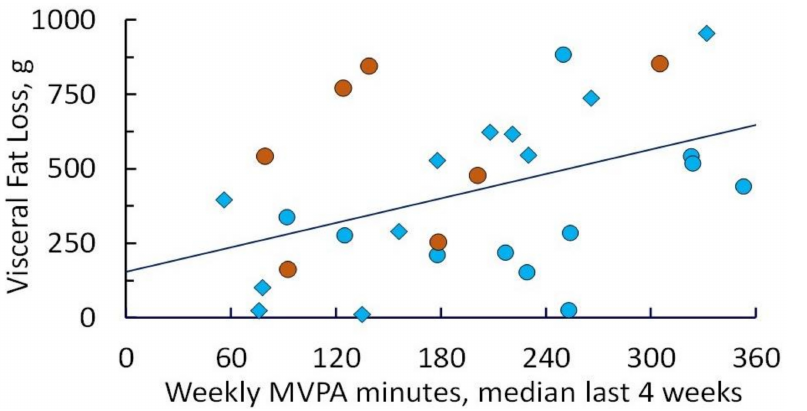
Figure 4. Visceral fat lost (percent relative to baseline) as assessed by iDXA after 12 and 24 weeks of intervention, plotted as a function of weekly MVPA achieved (median of recorded values for weeks 9–12 or weeks 21–24). Diamonds denote participants in cohort 1; circles denote participants in cohort 2 (blue = 12-week values; orange = 24-week values). Linear regression yields a slope of 0.063% visceral fat loss per min of MVPA ( p =